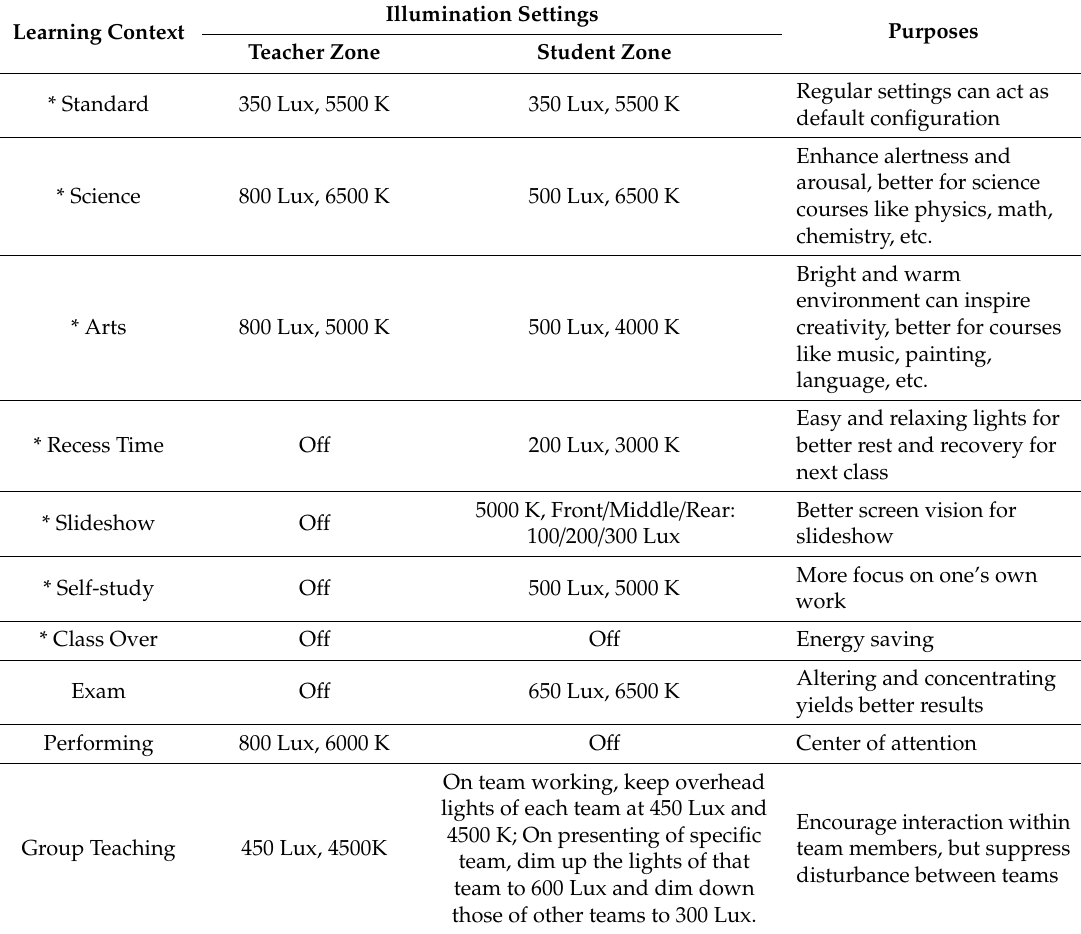
Table 12. Ten proposed lighting modes for common learning